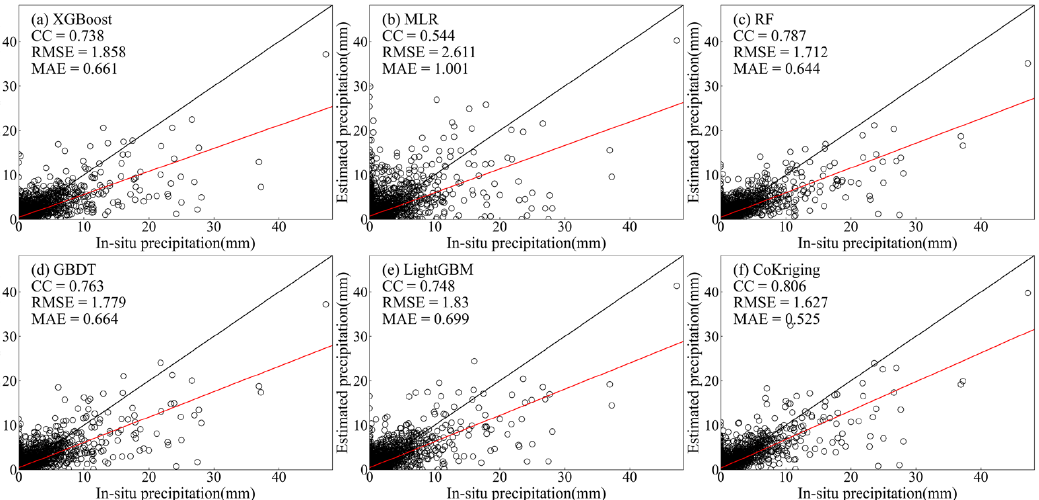
Figure 3. Comparison of the observed and estimated precipitation for heavy rainfall event I : (a) XGBoost, (b) MLR, (c) RF, (d) GBDT, (e) LightGBM, (f) CoKriging (the red line represents the fitted curve between in-situ and estimated precipitation; the black line represents that the ratio of in-situ precipitation to estimate precipitation is 1:1).